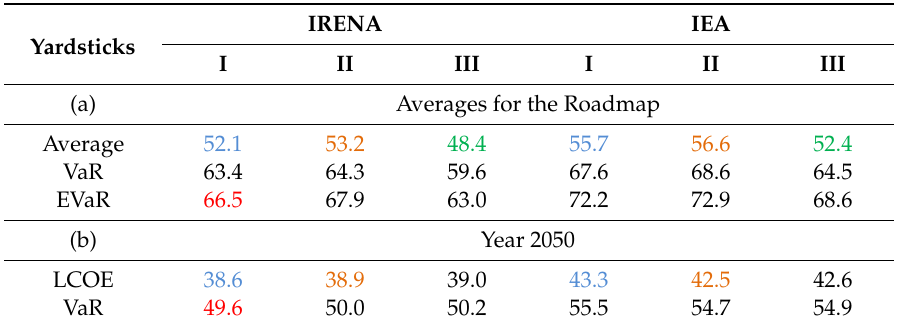
Table 1. Levelized cost of energy (LCOE) [USD / MWh]: Values and risk analysis. Value at risk (VaR) and expected value at risk